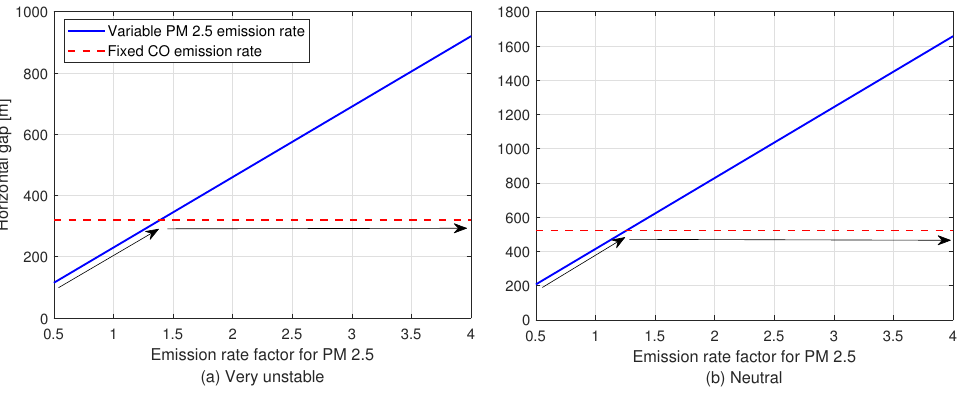
Figure 10. The impact of the PM2.5 emission rate on the horizontal gap while keeping the CO emission rate constant. The black arrow indicates the chosen optimal value of the horizontal gap when the PM2.5 pollutant’s rate factor is changed while the CO pollutant’s rate remains constant.